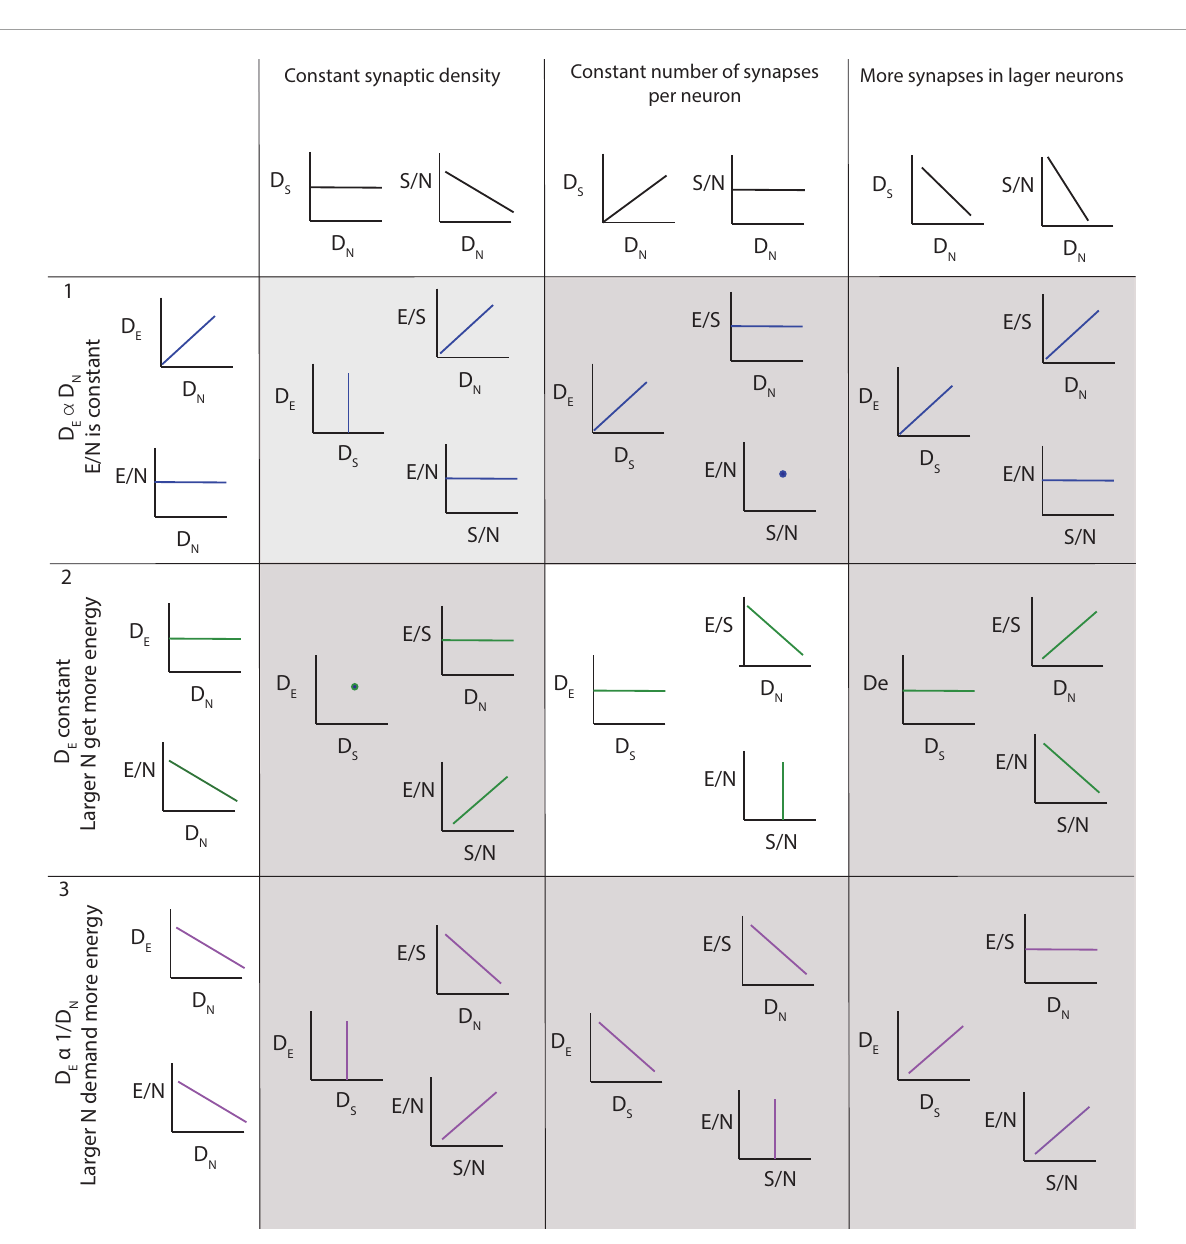
FIGURE3 Three of several possible scenarios of relationships among local density of capillary cells (D E ), local density of neurons (D N ), energy available per neuron (E/N, estimated as D E /D N ), local density of synapses (D S ), average number of synapses per neuron (S/N) and average energy supply per synapse (E/S). Scenario 1 (top row): neurons demand a certain fixed supply of energy, and the capillary bed adjusts to supply it at a steady-state, such that energy supply per neuron is constant across sites. D E is expected to be proportional to D N , and energy available per neuron (E/N) is constant. Scenario 2 (second row) : capillary supply to brain tissue is constant and neurons compete for energy available. In this case, D E is expected to be relatively constant regardless of local D N ; as a result, E/N is larger in sites of lower neuronal densities, where fewer neurons compete for a limited supply of energy. This is the scenario supported by our findings, but incompatible with current models. Scenario 3 (third row) : larger neurons demand more energy, and the capillary bed adjusts to supply it, such that energy supply per neuron is larger